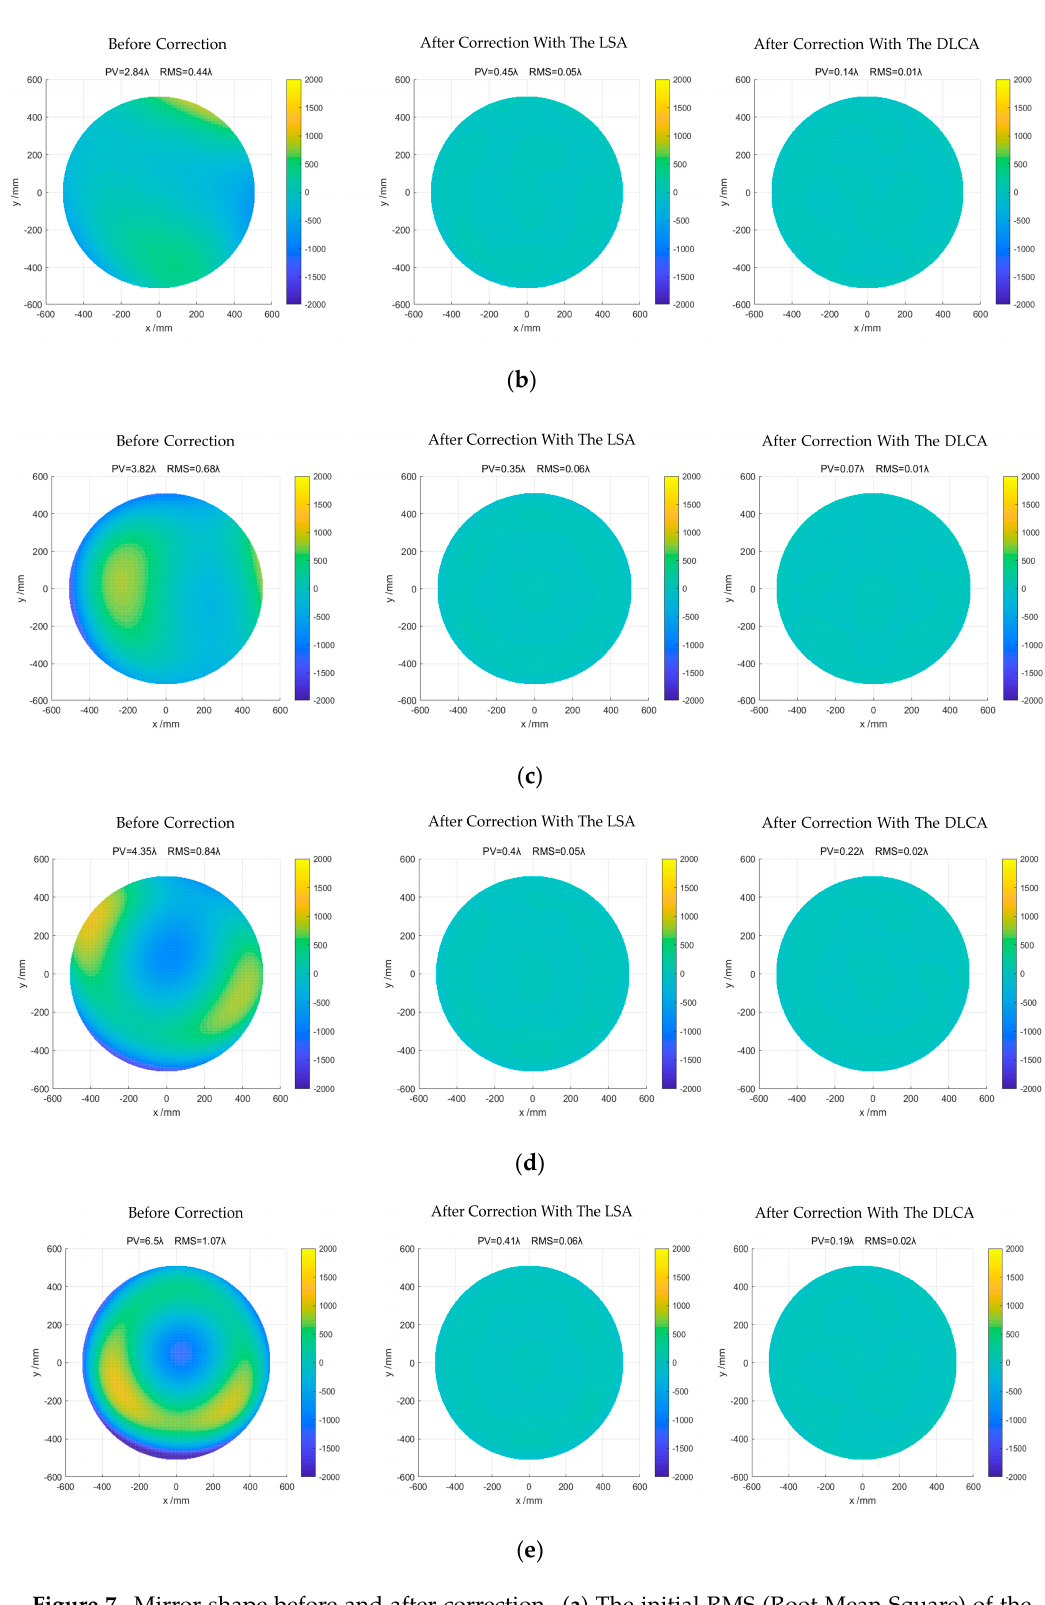
Figure 7. Mirror shape before and after correction. ( a ) The initial RMS (Root Mean Square) of the mirror is 0.26 λ ; ( b ) The initial RMS of the mirror is 0.44 λ ; ( c ) The initial RMS of the mirror is 0.68 λ ; ( d ) The initial RMS of the mirror is 0.84 λ ; ( e ) The initial RMS of the mirror is 1.07 λ . Apparently, the deformation of the mirror was modified by the two algorithms after correction. Notably, the correction performance of the DLCA is always better than the LSA regardless of the initial mirror shape. The detailed correction results of the LSA and the DLCA are shown in Table 3.